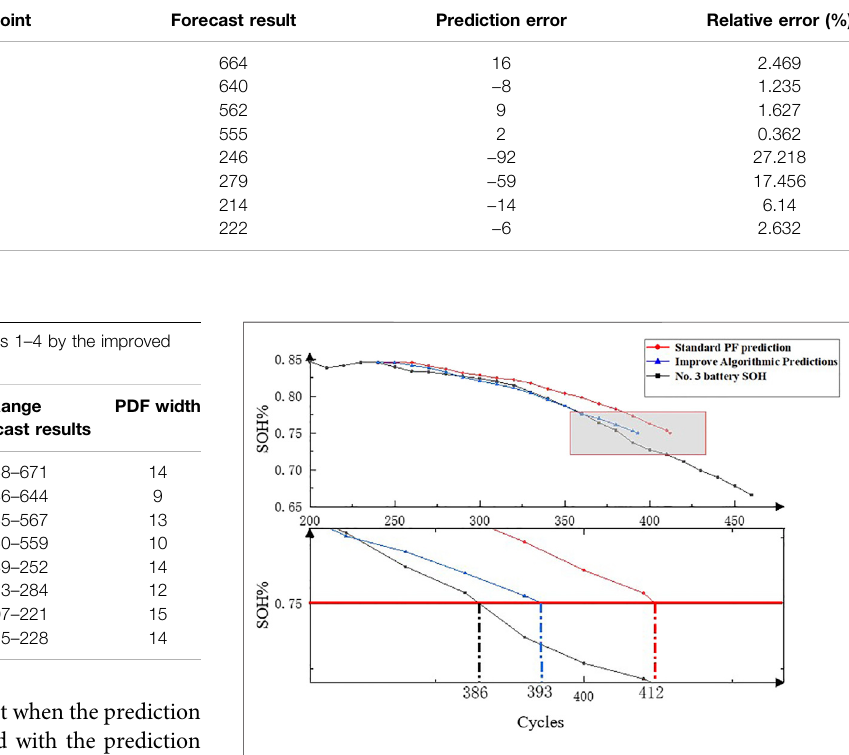
FIGURE 10 | Singular value comparison